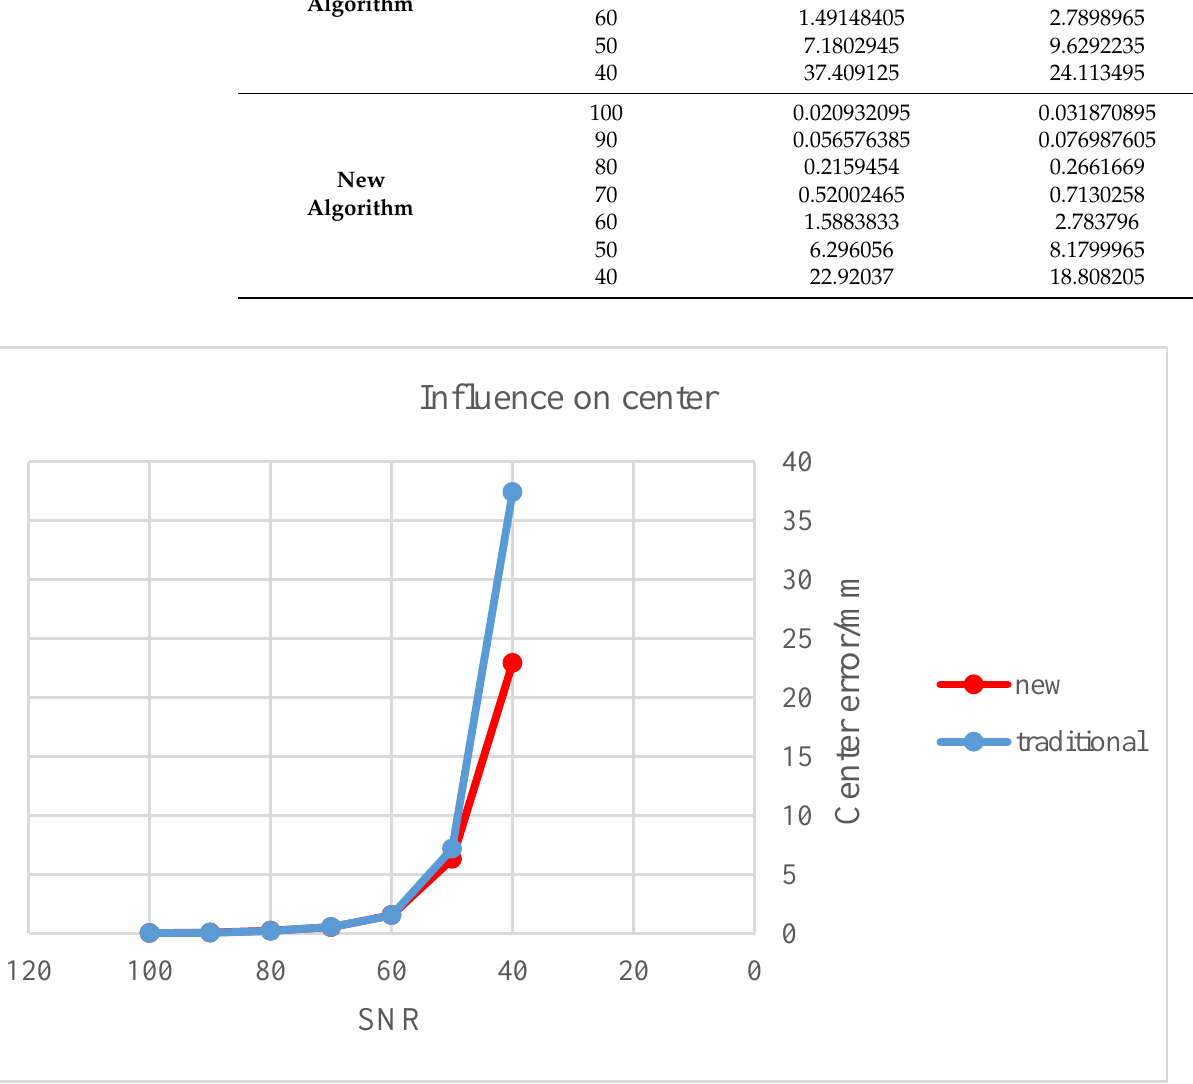
Figure 7. Influence of elliptical edge on center of space circular target.